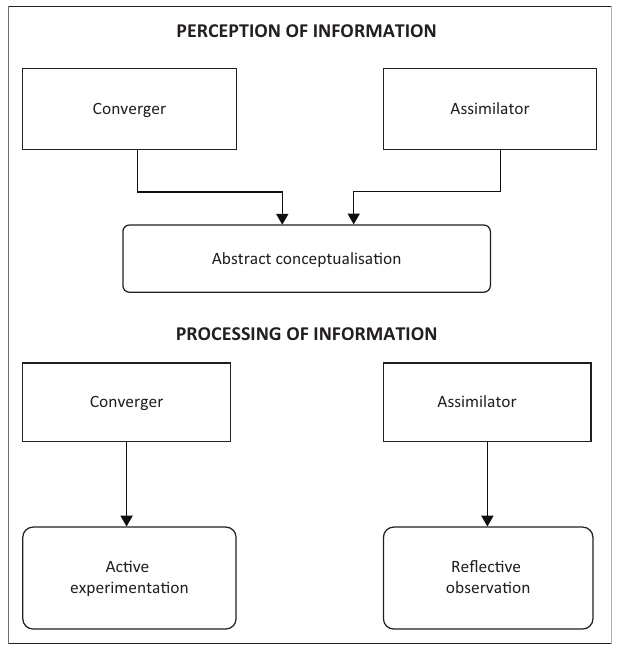
FIGURE 4: The perception and processing of information of the converger and assimilator learning